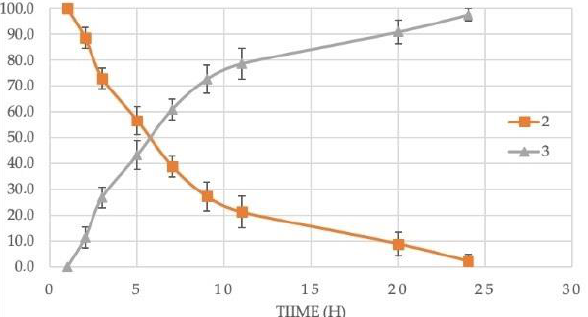
Figure 4. Time course of 2-AG alcoholysis performed with MML/ 2 (3/1), 1-octanol/ 2 (9/1) in TBDME at room temperature. Reaction progression was followed by GC and mixture composition is ex- pressed in percentage. 2 = 1,3-dibenzoate-2-AG; 3 =